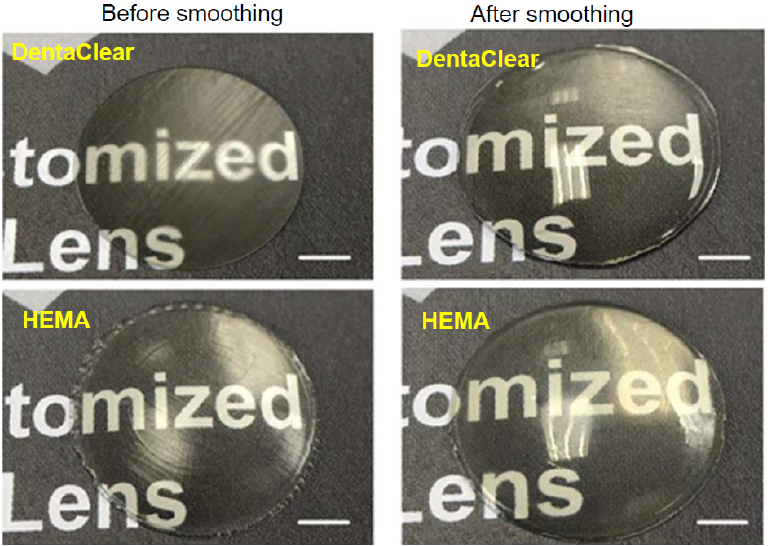
Figure 5. ( a ) Images of DentaClear lenses before (left) and after smoothing (right). ( b ) Images of Figure 5. ( top ) Images of DentaClear lenses before (left) and after smoothing (right). ( bottom ) Images HEMA lenses before (left) and after smoothing (right). Scale bars: 0.5 mm. of HEMA lenses before (left) and after smoothing (right). Scale bars: 0.5